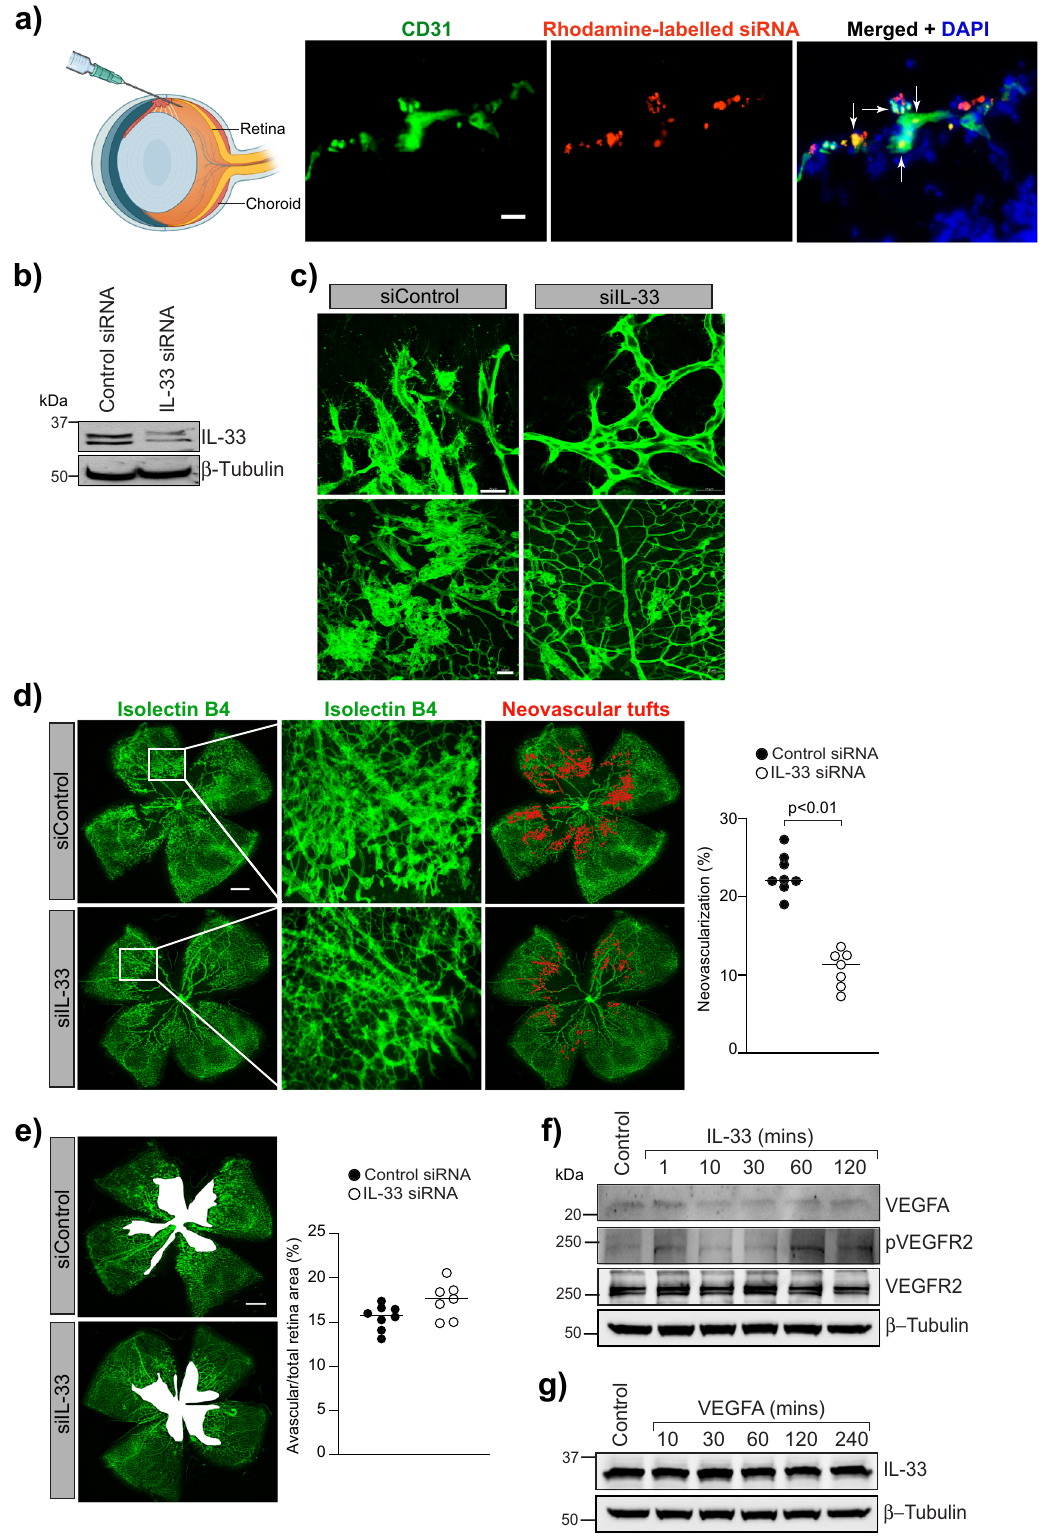
and NFkappaB in HRMVECs (Fig. 6h) and blockade of NFkappaB activation by QNZ (4- N -[2-(4-Phenoxyphenyl) ethyl]-1,2-dihydroquinazoline-4,6-diamine), signi fi cantly reduced IL-33-induced Jagged1 expression in HRMVECs (Fig. 6i). We also observed increased activation of NFkappaB in hypoxic retinas (Fig. 6j), and genetic depletion of IL-33